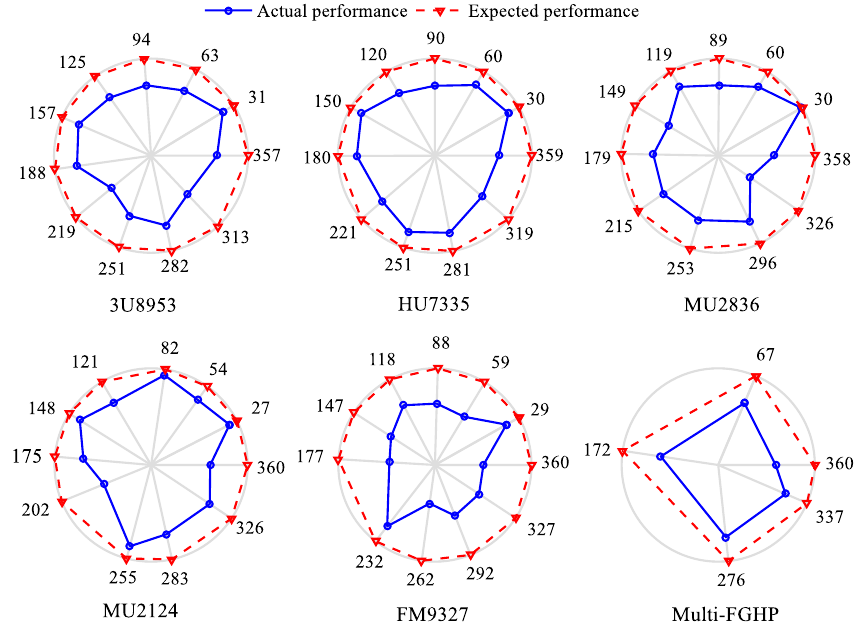
Figure 7. Multi-FGHP performance evaluation exhibition with radar charts at the current moment. Table 6. Multi-FGHP performance evaluation value for different flights at the current moment.